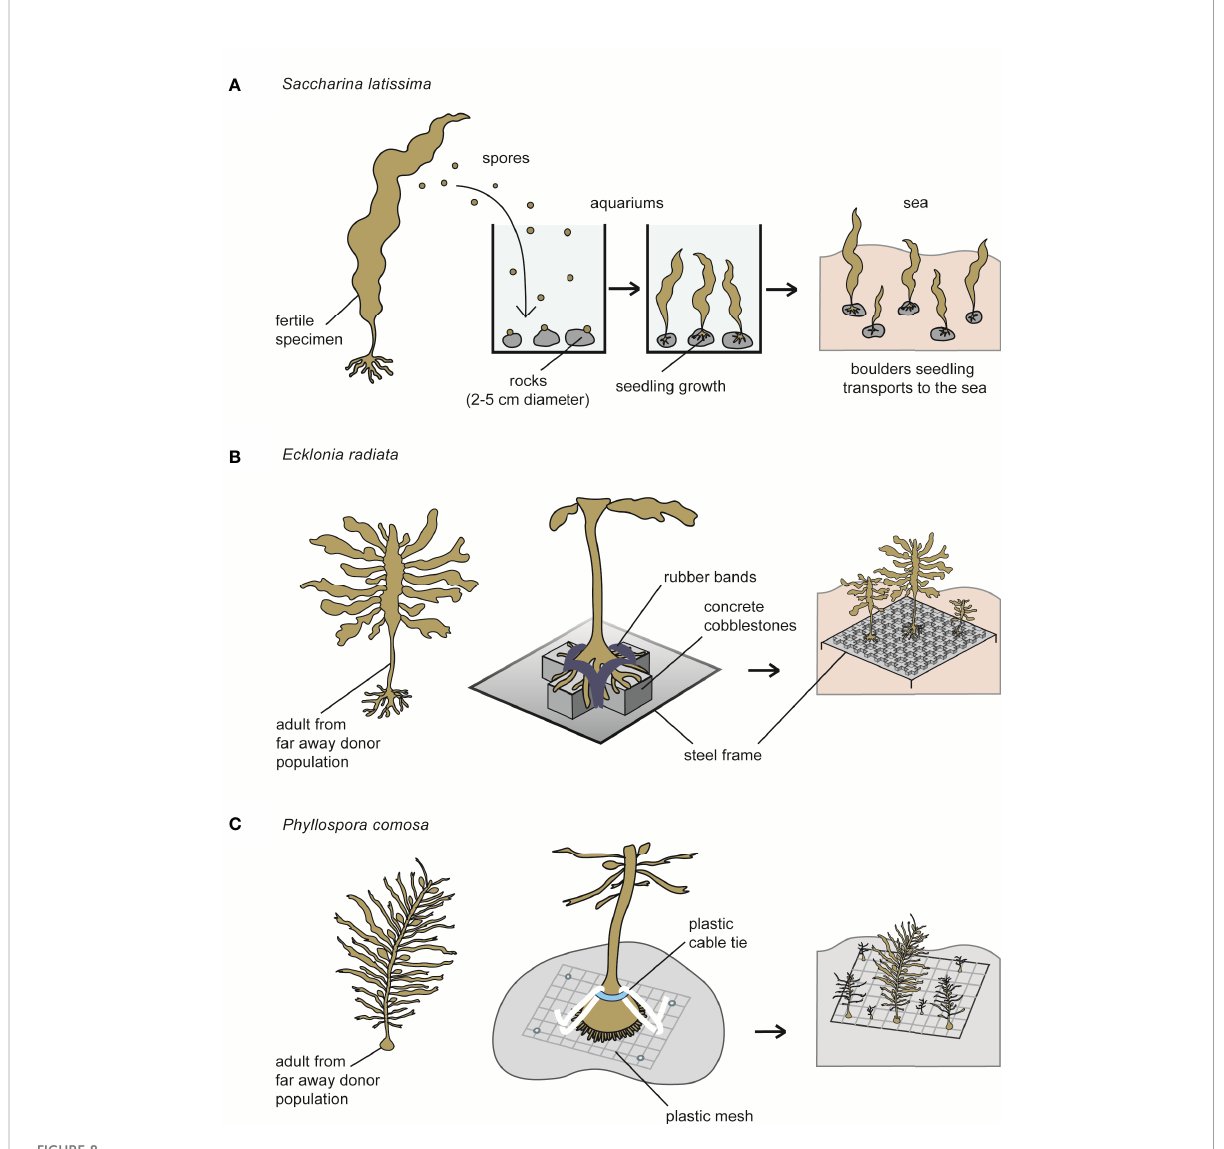
FIGURE 8 Some illustrations about restocking strategies used for brown seaweeds worldwide. (A) Saccharina latissima . (B) Ecklonia radiata . (C) Phyllospora comosa